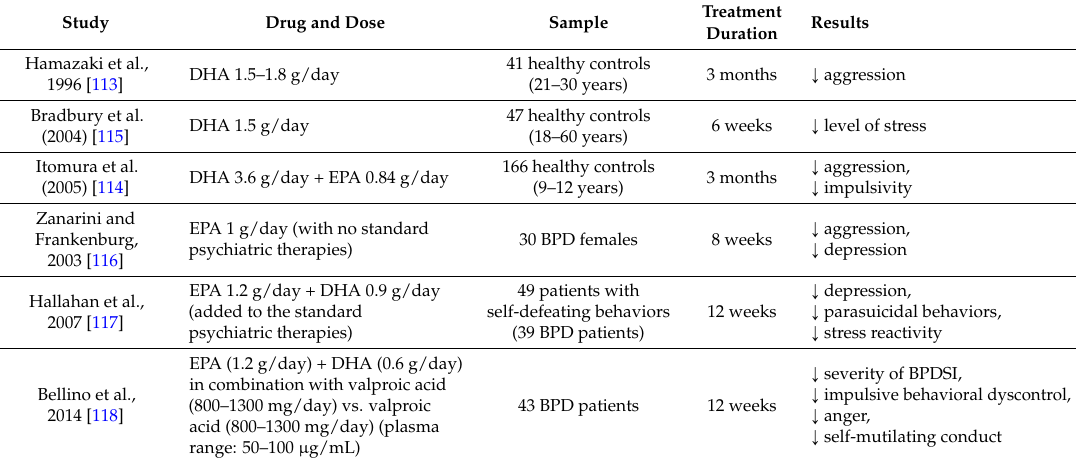
Table 5. Double-blind controlled trials of HUFAs in the treatment of impulsivity and borderline personality